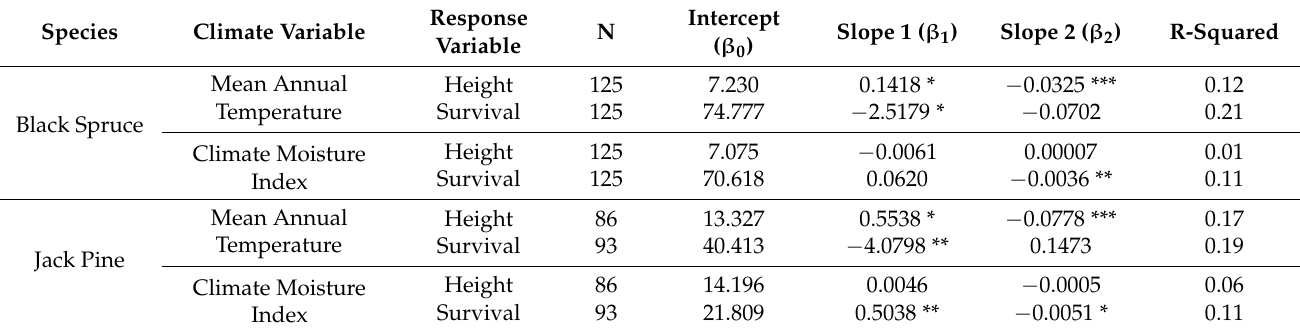
Table 1. Parameters from quadratic regression models between climate transfer distance and height/survival of northern seed sources used in rangewide provenance trials for black spruce and jack pine. Asterisks indicate level of statistical significance: * = p < 0.05, ** = p < 0.01, *** = p < 0.001.